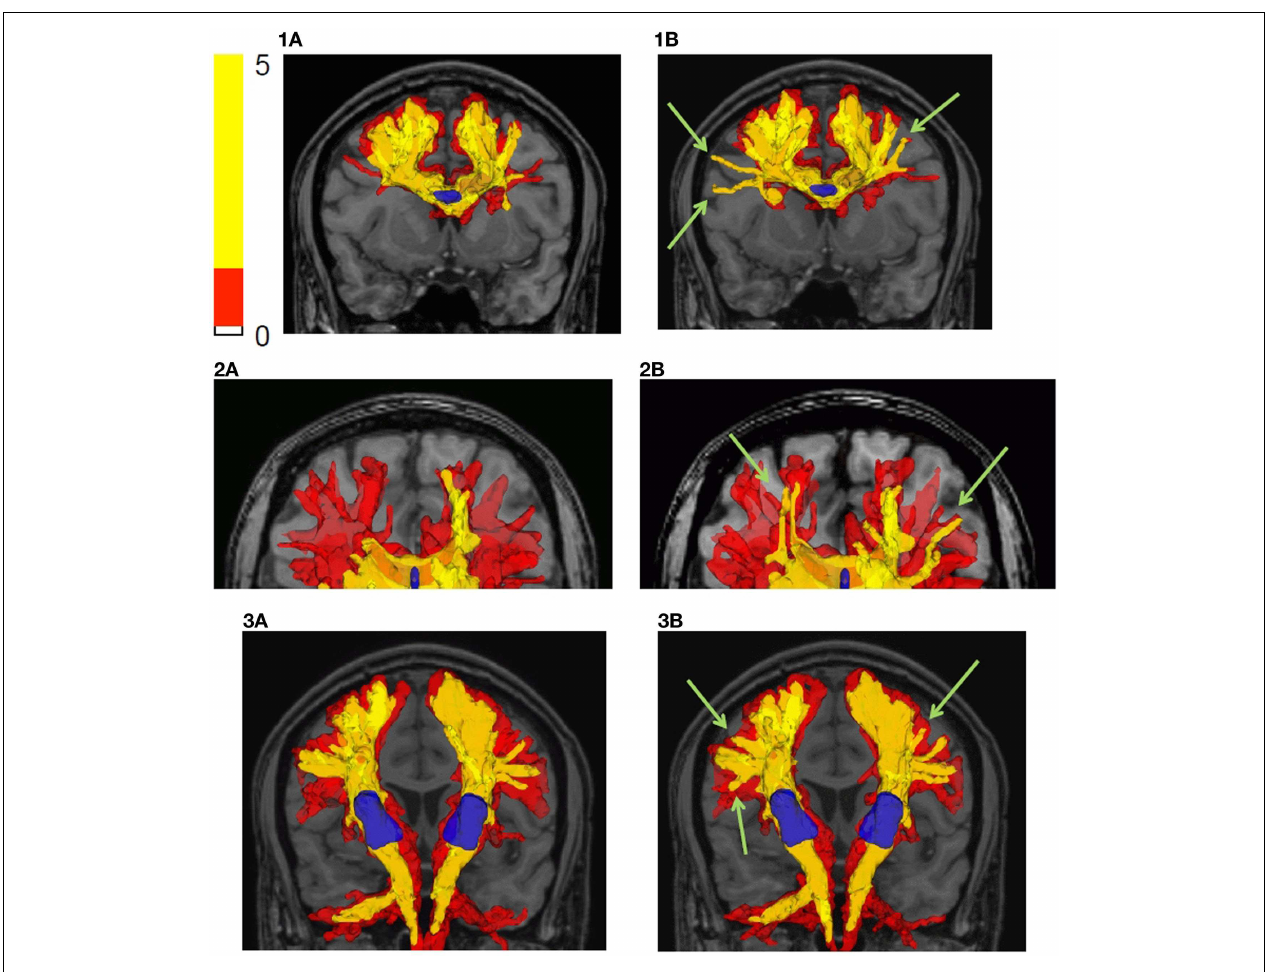
lowest non-zero connectivity index values, and the yellow surface is a higher isosurface of the connectivity index map (shown in legend). Row (1) is the result using a seed ROI in the center of the corpus callosum, row (2) is the result starting in the genu of the corpus callosum, and row (3) is the result using an internal capsule seed ROI.The reference ROIs are shown in